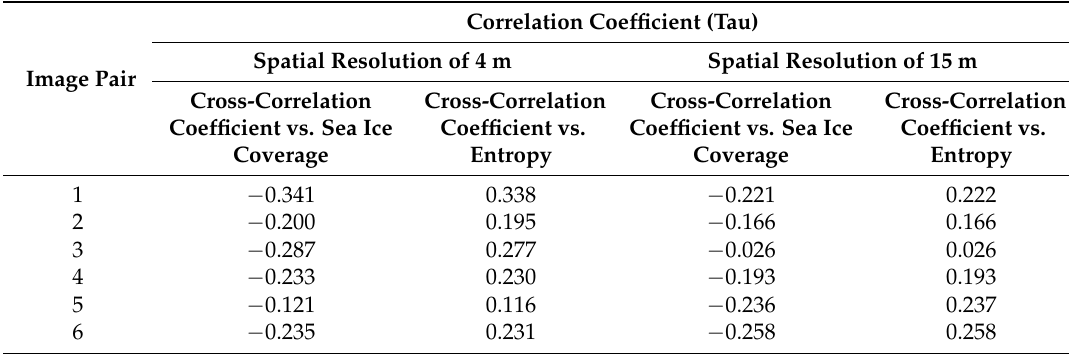
Table 6. The relationships between cross-correlation coefficient and sea ice image